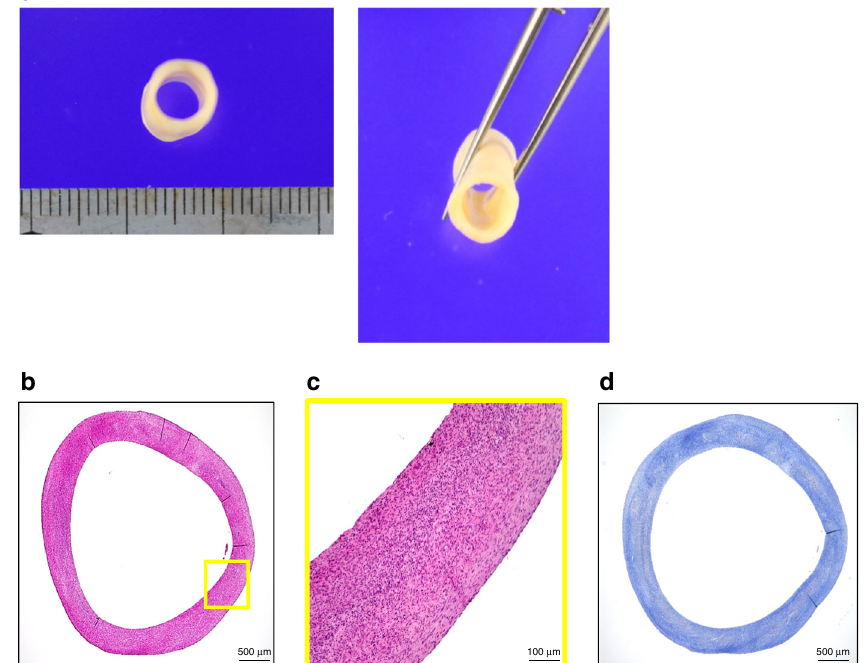
Fig. 2 Macroscopic photographs and micrographs of the HOBPT. The HOBPT had an inner diameter of 5 mm and a soft, elastic texture a . Microscopically, the HOBPT was composed of human fi broblasts and collagenous extracellular matrix b , c , stained blue by Masson – trichrome staining d . No endothelial cells were seen on the luminal surface of the HOBPT c . Scale bar: 500 µ m in b , d , 100 µ m in c . HOBPT: human original 3D bioprinted tube